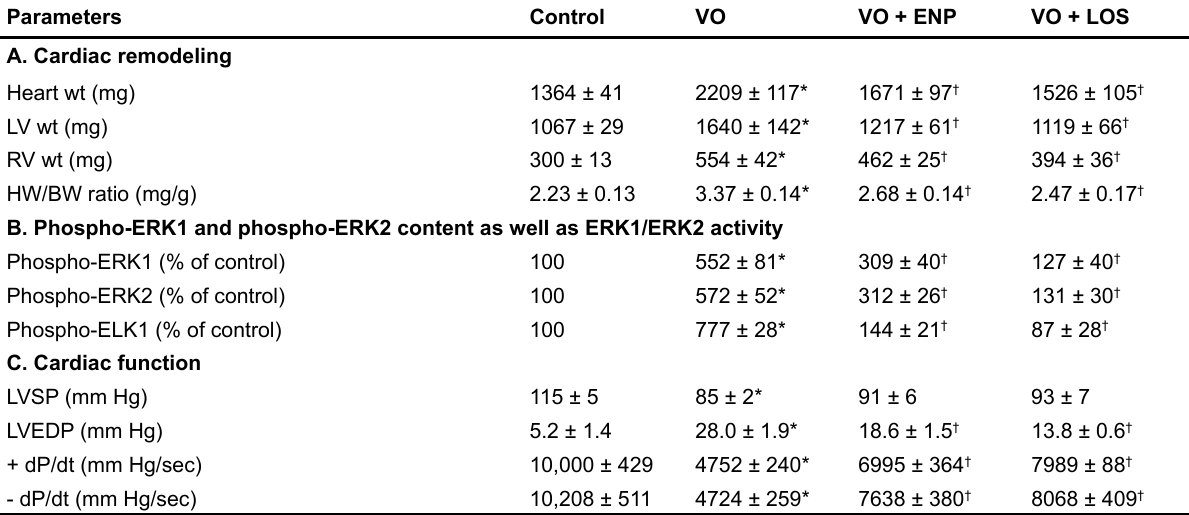
BW: body weight; HW: heart weight. Data are based on the analysis of the information in Table 2 and Figures 3, 4 and 5 in our paper Zhang et al. J Cardiovasc Pharmacol Ther. 2010;15:84-92 [168]. * P < 0.05 compared with control; † P < 0.05 compared with VO